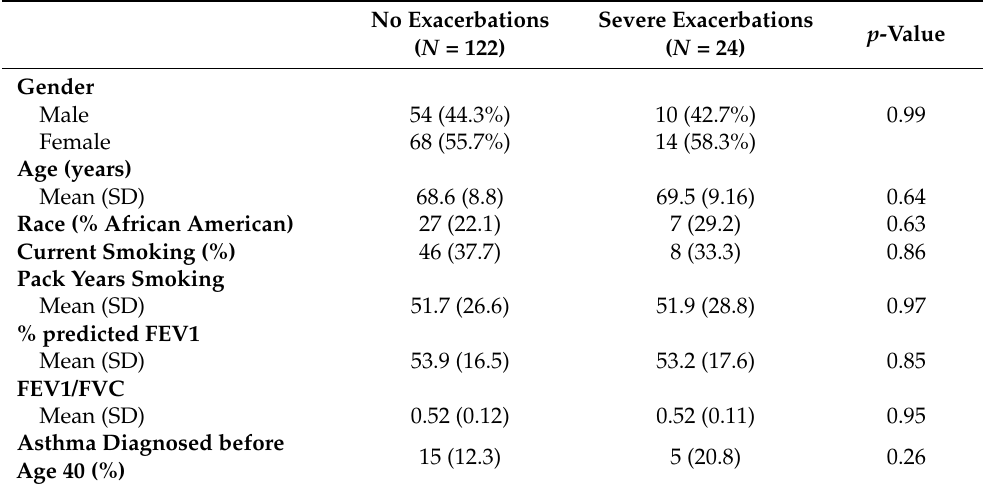
Table 2. Baseline Epidemiologic and Clinical Characteristics of